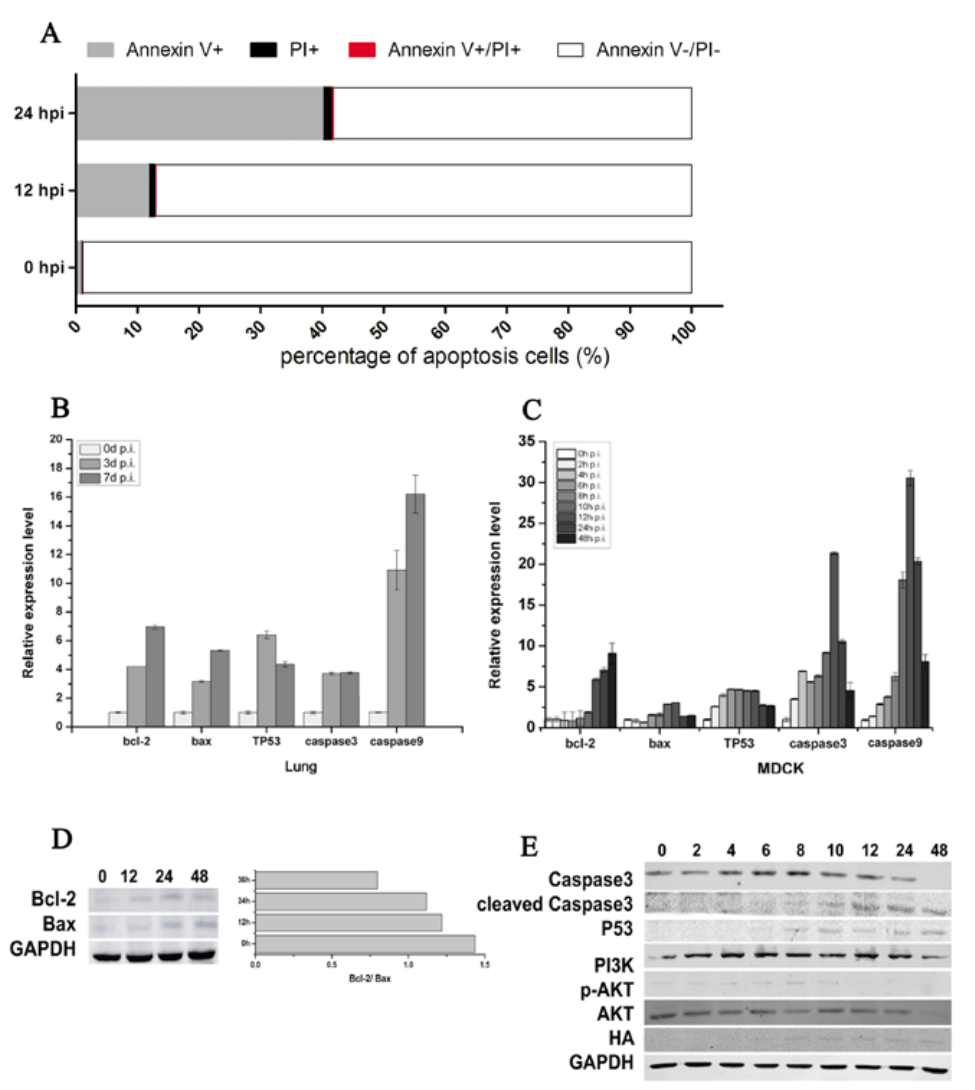
Figure 3. CIV H3N2-induced apoptosis. Cell apoptosis was assessed using an Annexin-APC/PI (Propidium Iodide) apoptosis kit for flow cytometry ( A ); Lungs and cells were collected to isolate RNA at specific time points. Real-time qPCR was performed to detect the expression of the apoptosis-associated genes bcl-2, bax, TP53, caspase3, and caspase9, and relative expression levels are shown according to the ratio of the infected and uninfected groups at each time point ( B , C ); In addition, apoptosis-associated proteins were detected by Western blotting ( D , E ).